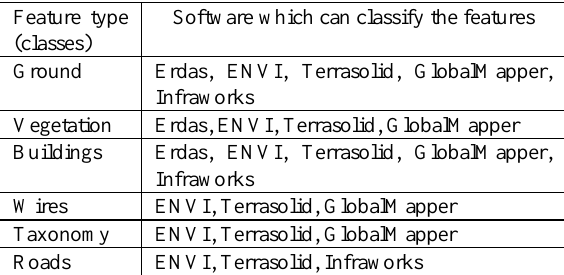
Table 1. Abilities for classification of software in question